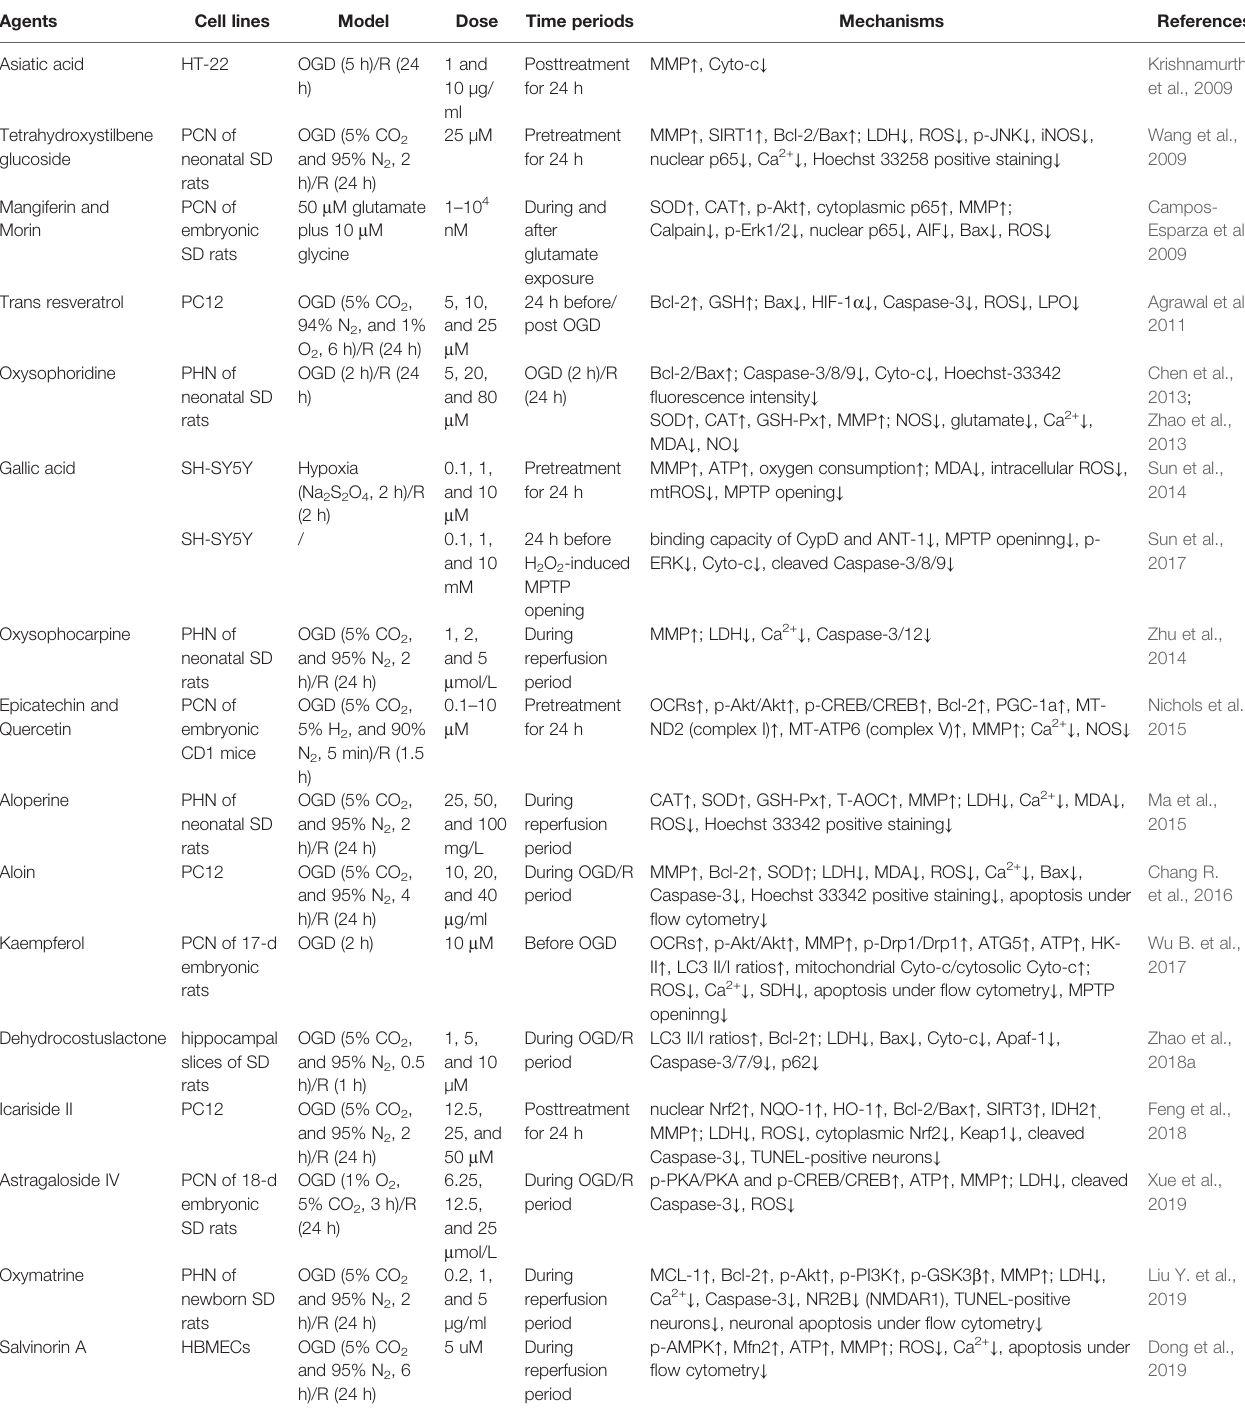
TABLE 7 | The in vitro mechanism underlying the inhibition of MPTP opening-induced neuronal apoptosis by monomeric compounds in the treatment of ischemic stroke.